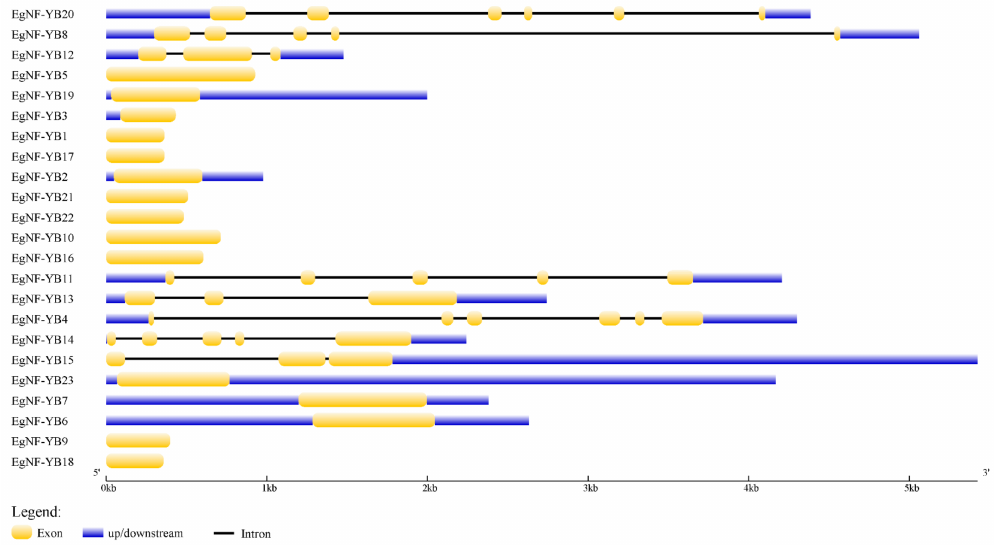
Figure 3. Exon-intron gene structures of EgNF-YB . Gene structure analysis was performed using GSDS. Length of exons and introns for each EgNF-YB gene is proportionally